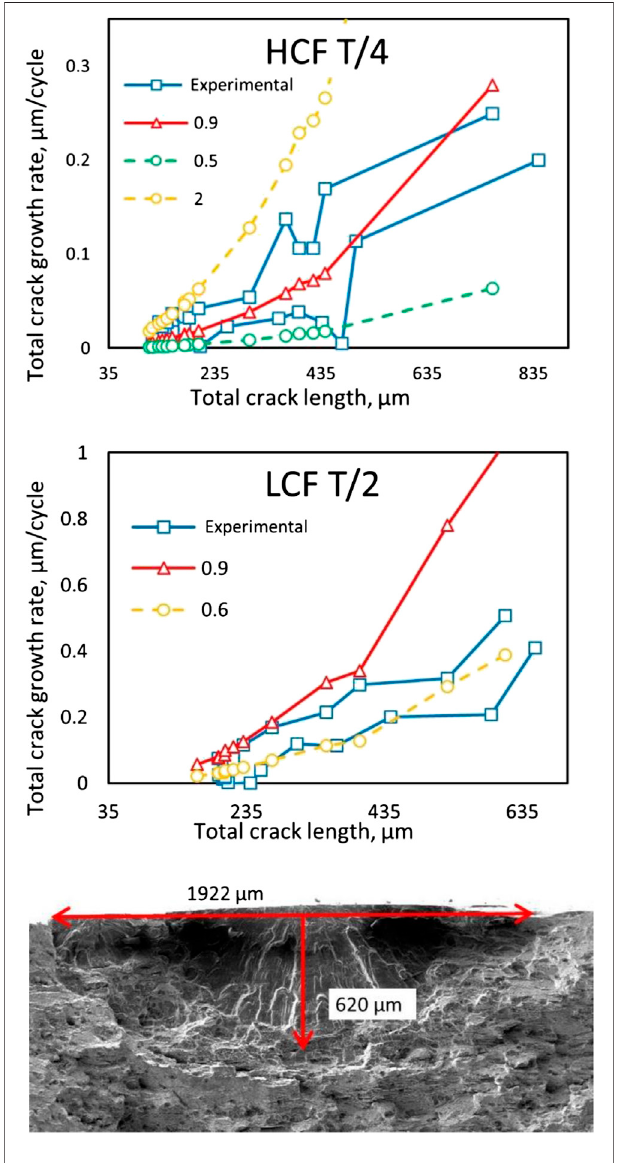
FIGURE9|(A) Effect ofcrack depthonthe FGCRofspecimenHCFT/4 for crack aspect ratios of 0.5, 0.9, and 2.0 (B) Experimental vs. model results forsampleLCFT/2,showingmodelresultsassuminganaspectratioof0.9vs. the actual aspect ratio of 0.6 (C) The fracture surface and fi nal aspect ratio of the crack seen observed on sample LCF T/2.